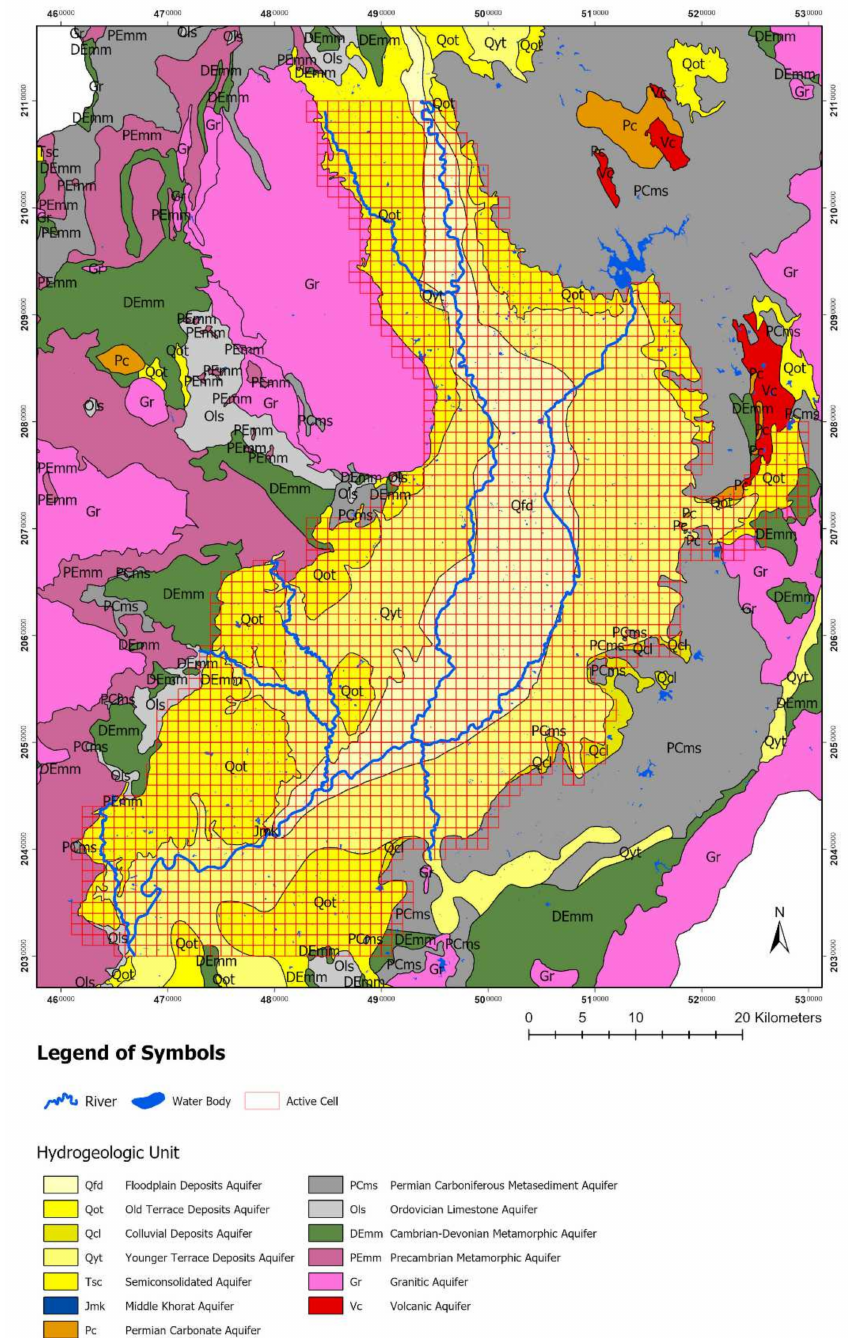
Figure 7. Finite-difference grid used to simulate groundwater flow (top